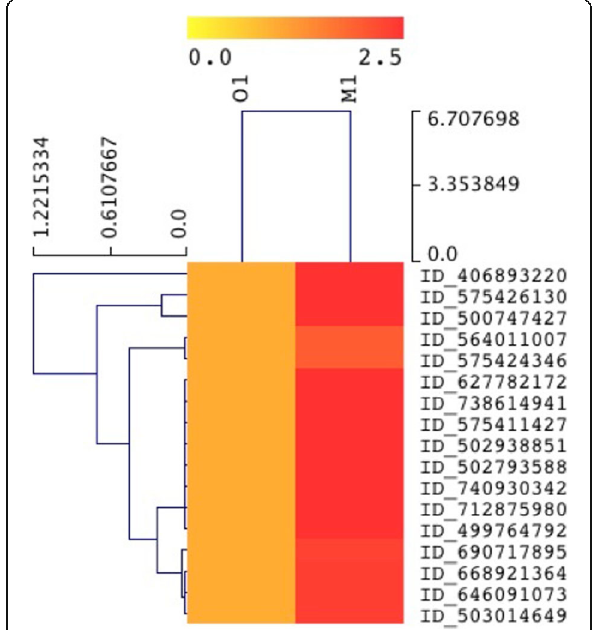
Fig. 5 Heat map showing expression of genes involved in aromatic compound degradation in M1 compared to O1 with p value ≤ 0.05. The detailed description of the genes is provided in Table 3